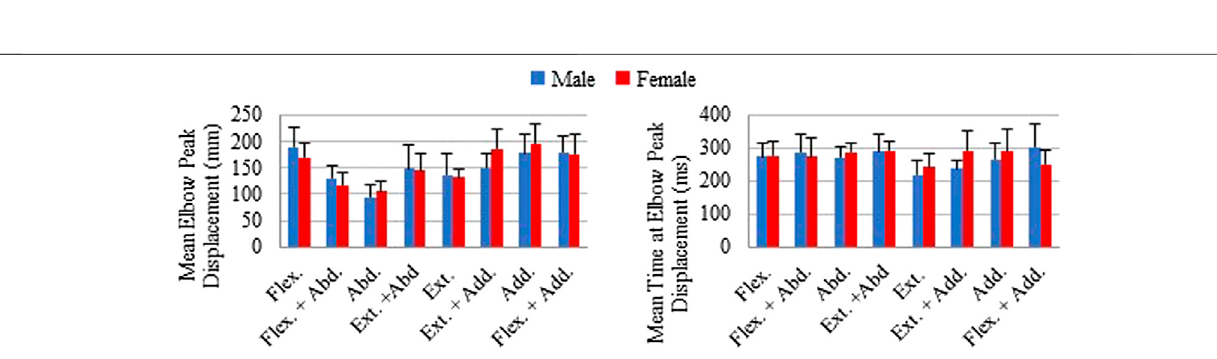
Frontiers in Bioengineering and Biotechnology |